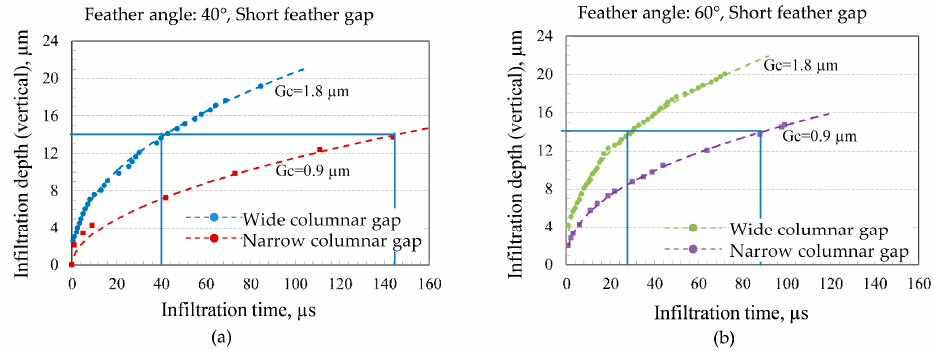
Figure 14. CMAS infiltration behavior for narrow and wide columnar gaps for short feather arm model: ( a ) Comparison for 40° inclined feather arm models; ( b ) comparison for 60° inclined feather arm models.